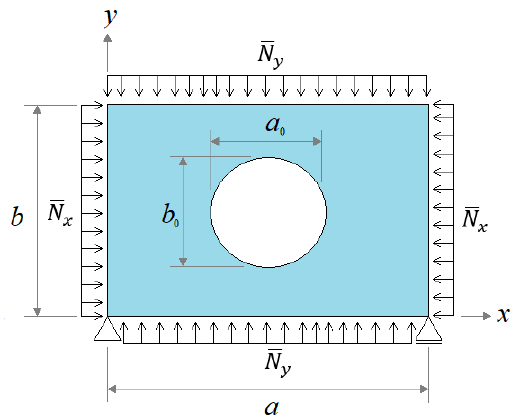
Figure 7. Simply supported square plate with centered circular hole.